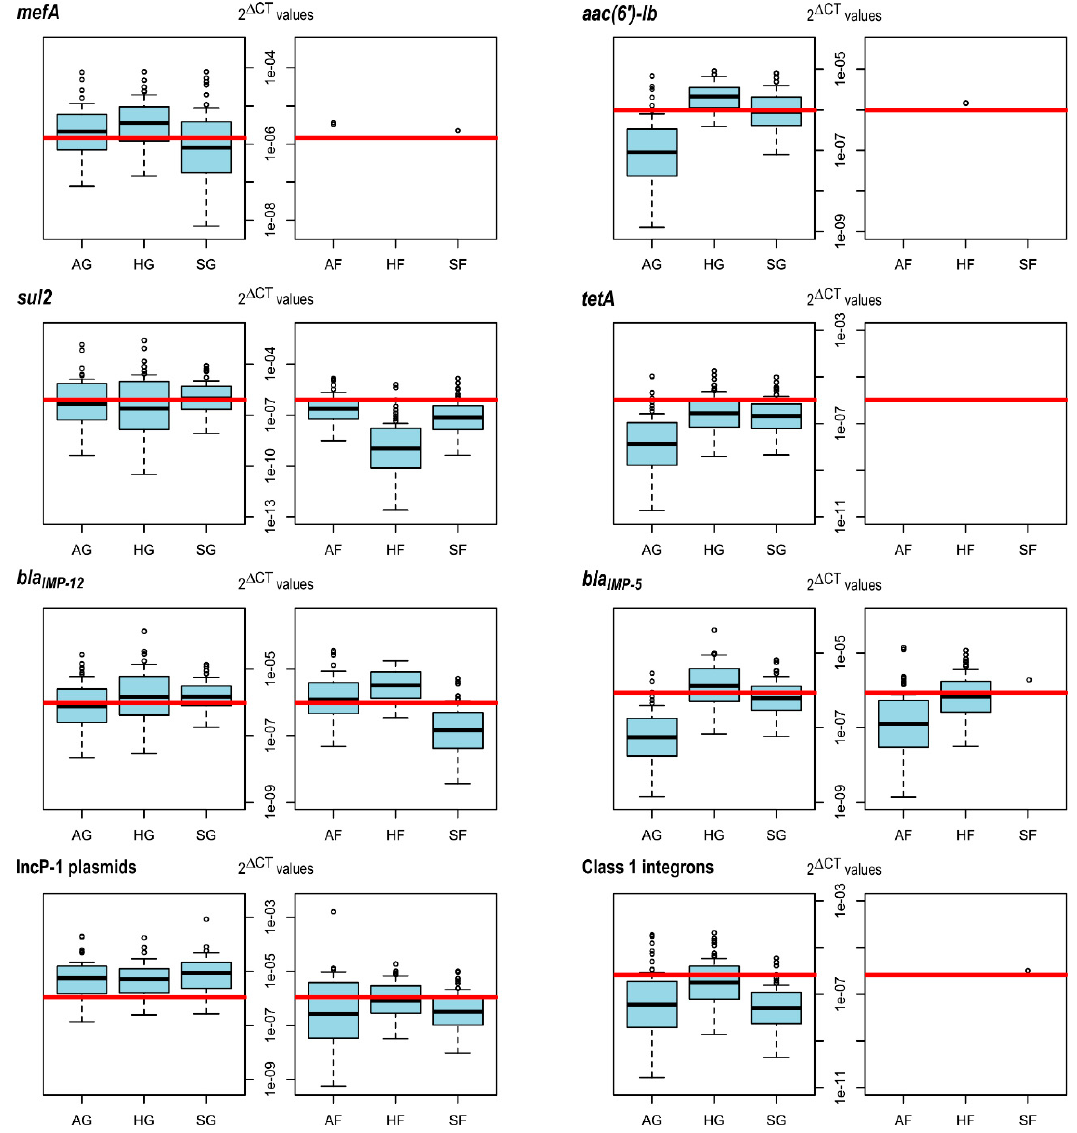
Figure 1. Censored boxplots depicting 2 ∆ CT values of quantified antibiotic resistance genes and mobile genetic elements. The red horizontal line indicates the highest censoring threshold. Everything below this line was estimated. The whiskers represent 1.5 times the outer quartile range. AG, HG and SG represent Schwäbische-Alb, Hainich-Dün and Schorfheide-Chorin grassland soils, respectively, whereas AF, HF and SF represent Schwäbische-Alb, Hainich-Dün and Schorfheide-Chorin forest soils, respectively.